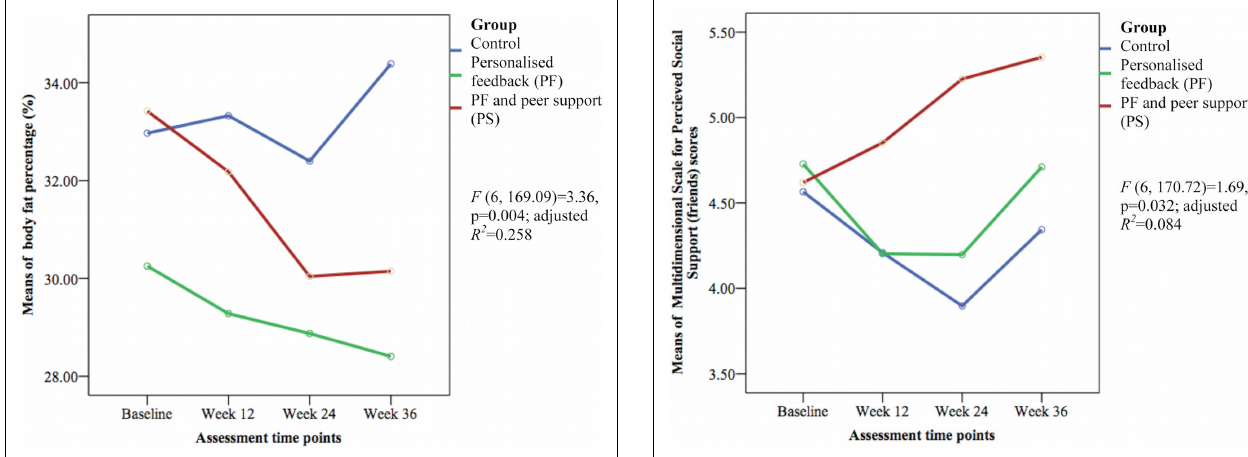
FIGURE 6 | Mean differences on body fat percentage between groups over time .